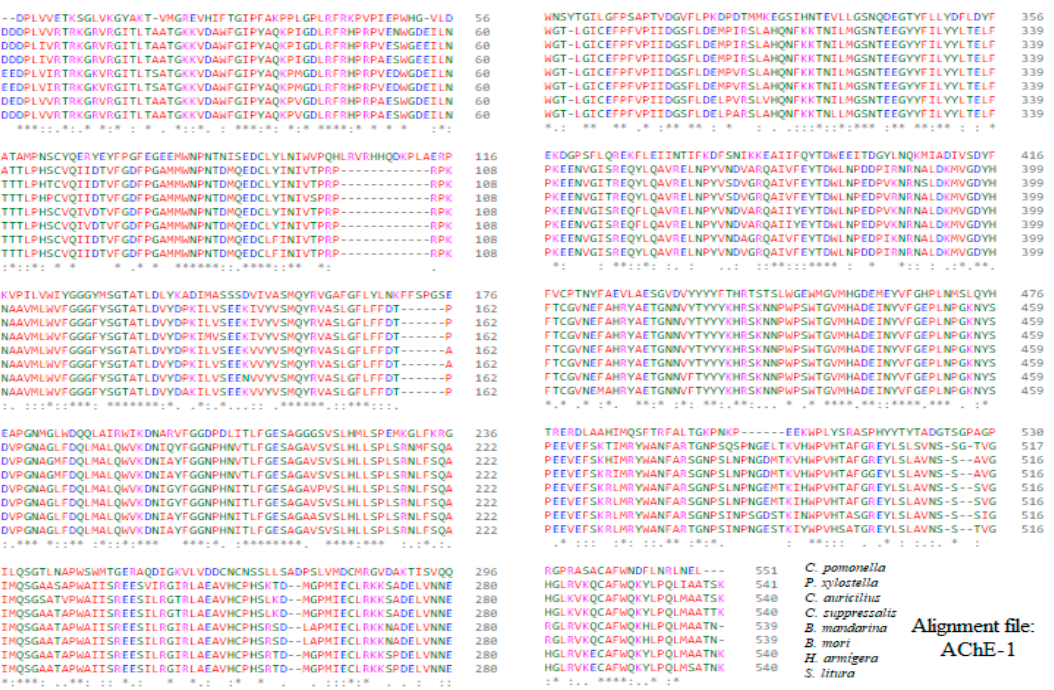
Figure A1. Alignment of the sequences of the constructed molecular models of AChE-1 (form 1 acetylcholinesterase).